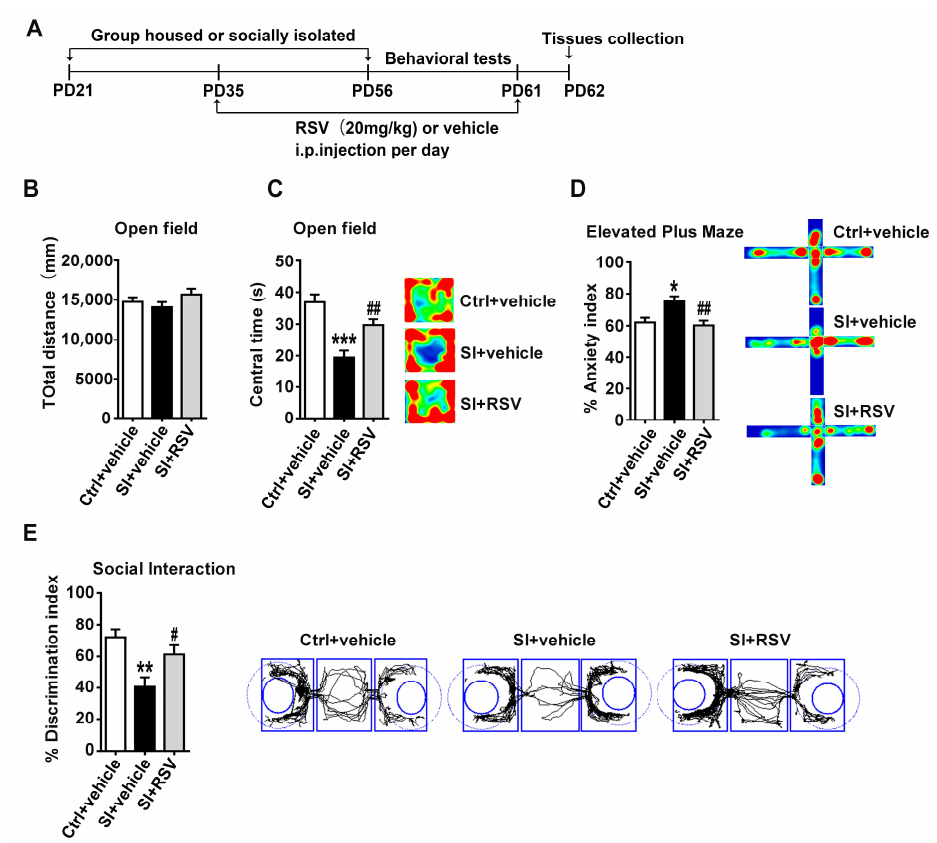
Figure 4. The protective effects of resveratrol on adolescent social-isolation-induced behavioral abnormalities in female rats: ( A ) experimental design for the resveratrol treatments procedure and tissues collection: ( B , C ) total distance and central time in the open test among all groups; ( D ) resveratrol treatment significantly reduced the anxiety index when compared to vehicle-treated isolated female rats; ( E ) resveratrol improved social deficits compared with the vehicle-treated isolated female rats; analyses were performed using one-way ANOVA followed by Bonferroni’s multiple comparison post hoc test; data were presented as mean ± SEM; *** p < 0.001; ** p < 0.01; and * p < 0.05 compared to the Ctrl +vehicle group; ## p < 0.01 and # p < 0.05 compared to the SI+vehicle groups; Ctrl indicates control; SI indicates social isolation.